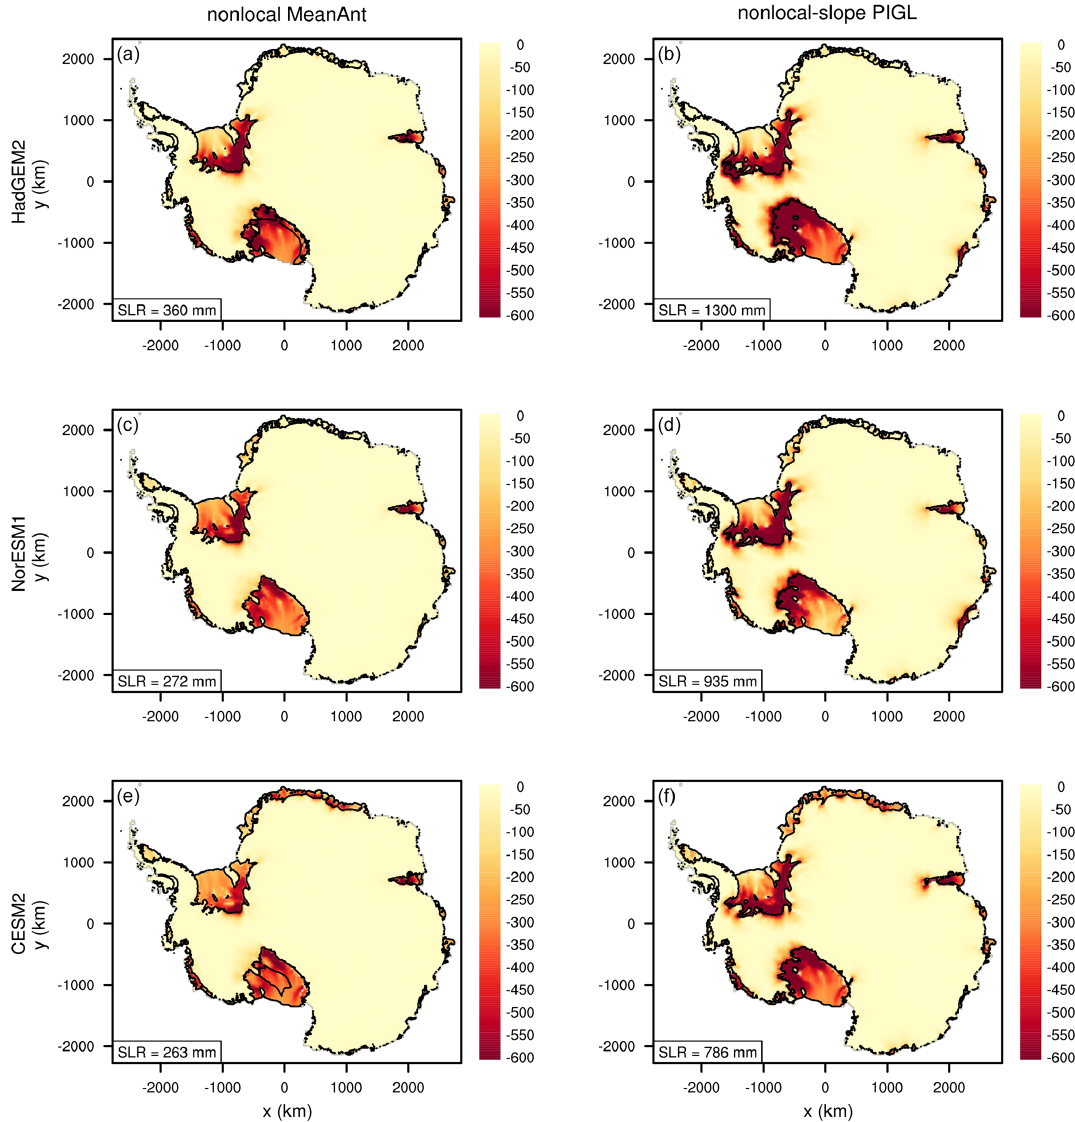
Figure 12. Difference in ice thickness (m) between years 2500 and 1950 in ocean-forced projection experiments. The left and right columns show results from the nonlocal-MeanAnt and nonlocal-slope-PIGL melt combinations, respectively. The three rows show results with ocean forcing from HadGEM2, NorESM1, and CESM2. Black lines show boundaries of floating ice at the end of each run. In the nonlocal HadGEM2 run (a) , retreat of the black line from the Ross calving front indicates shelf collapse. In the nonlocal CESM2 run (c) , the enclosed black contour shows that part of the Ross Ice Shelf interior has collapsed, without calving-front retreat. Boxes in the lower left of each panel show the SLR contribution from the loss of grounded